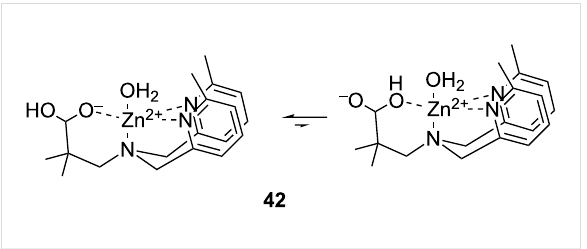
Figure 16: Nucleic acid cleaving agents where the attacking oxyanion is not coordinated to metal ion.